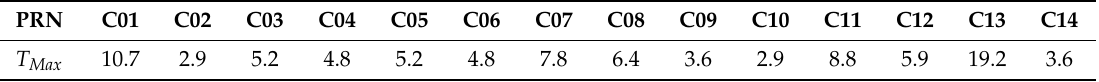
Table 1. Thresholds of orbital maneuver detection for XMIS in 2017 (unit: meter).